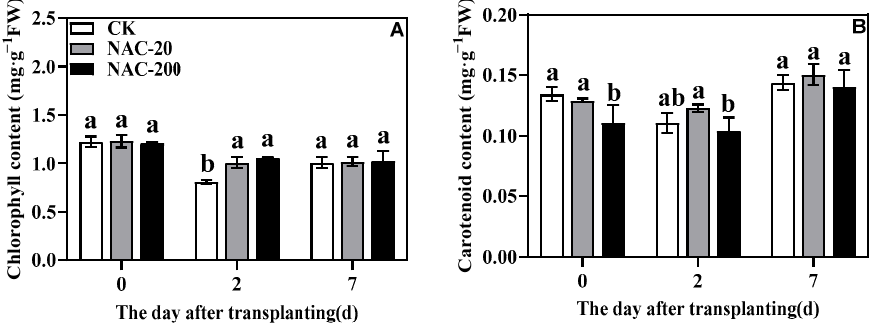
Figure 4. Effects of different concentrations of NAC on chlorophyll ( A ) and carotenoid ( B ) content. CK, 0 µ m; NAC-20, 20 µ m; NAC-200, 200 µ m. Data are means ± SD ( n = 3). The different letters following average values indicate significant difference (Duncan, p < 0.05).